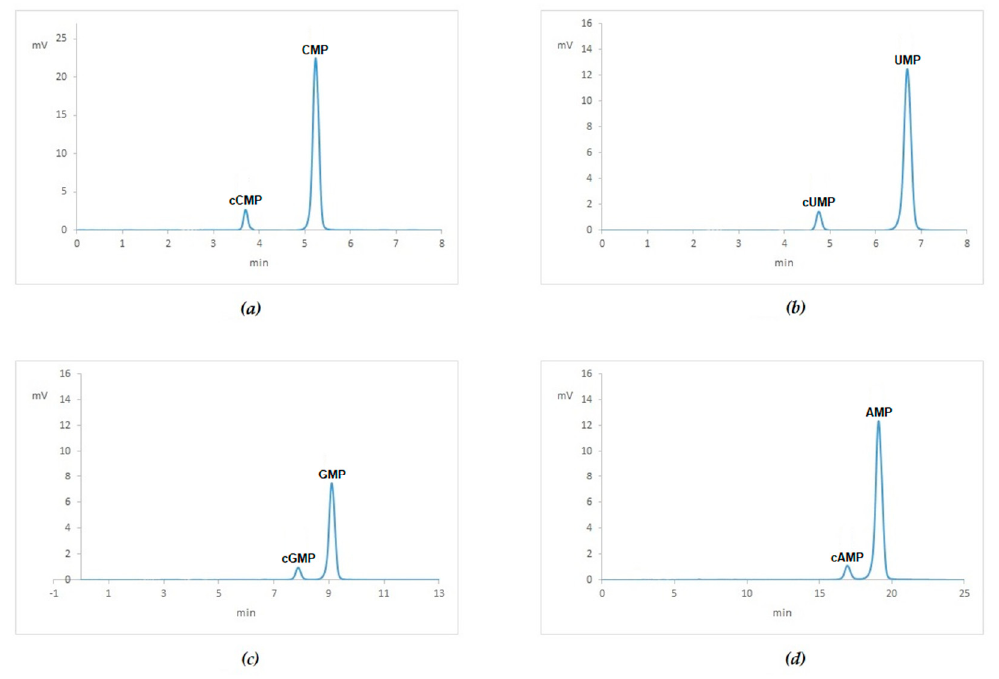
Figure 3. HPLC analysis of digested 15-mer mono-oligonucleotides: Chromatogram of digestions of polyC ( a ), polyU ( b ), polyG ( c ), polyA ( d ). Table 3. Results of the digestion by S1 Nuclease of each polyNMP: recovery percentage as ratio of the recovered amount from HPLC vs. the loaded one and ratio between NMP and cNMP (cyclic NMP)